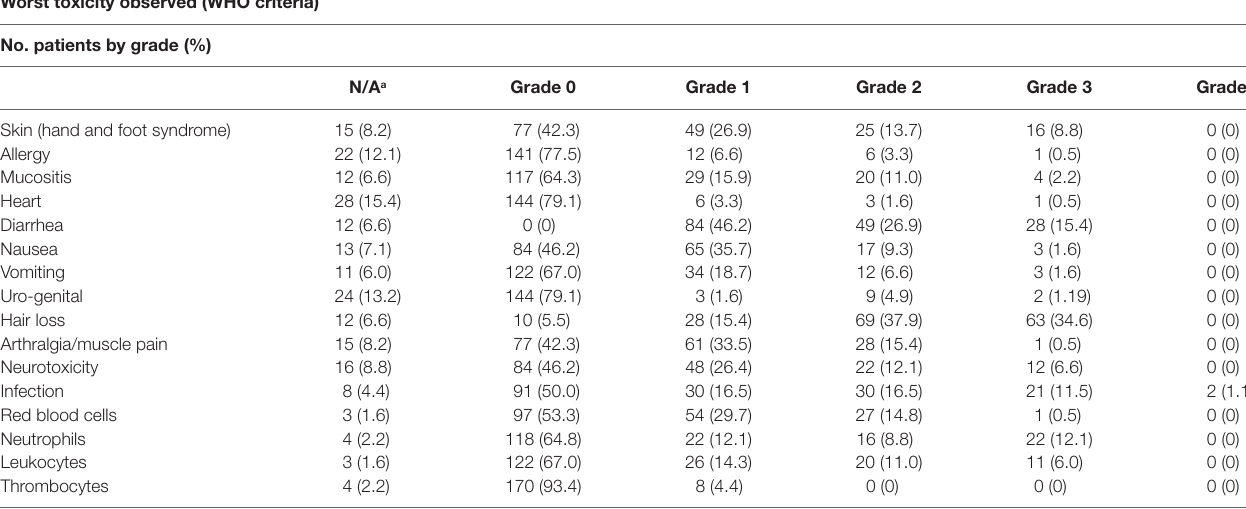
TaBlE 4 | Worst toxicity ( N = 182 patients. One patient did not receive any treatment). Worst toxicity observed (WHO criteria) no. patients by grade